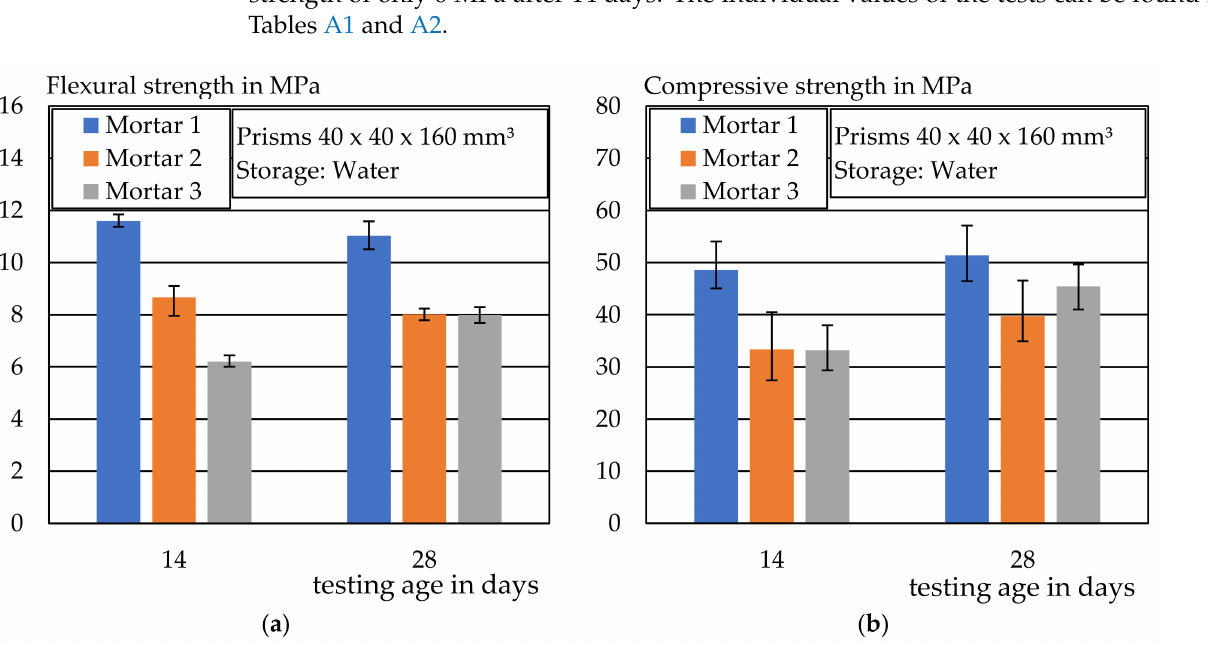
Figure 15. ( a ) Flexural strength of Mortar Mixes 1–3 after 14 and 28 days, ( b ) Mortar compressive strength of Mortar Mixes 1–3 after 14 and 28